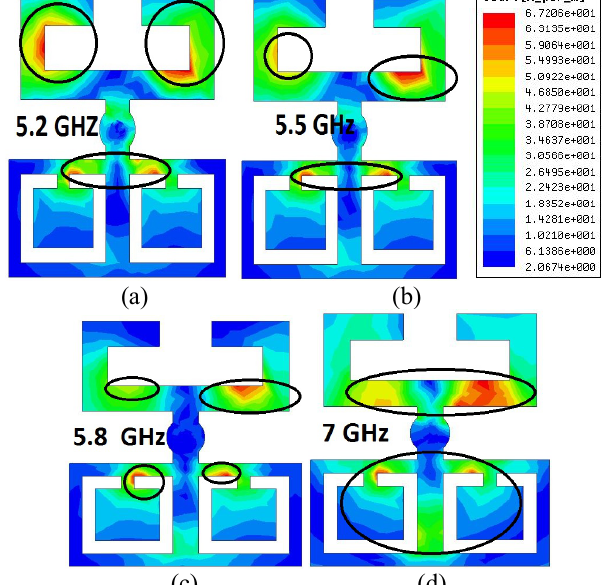
Figure 8. Current distribution of proposed design (a) 5.2, (b) 5.5, (c) 5.8 and (b) 7